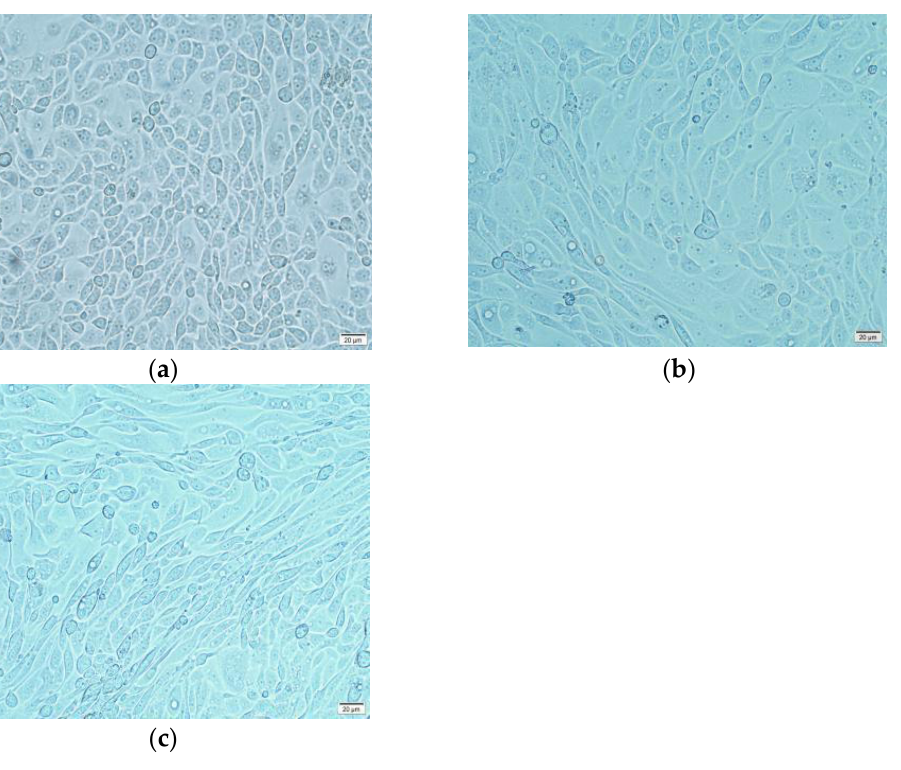
Figure 1. IPEC-J2 cell morphology under 200x inverted microscope. ( a ) Control group: cells were in a typical pebble-stone shape with clear boundary; ( b ) TGEV group: cells were elongated to a spindle shape; ( c ) TGF- β group: cells were elongated to a spindle shape.